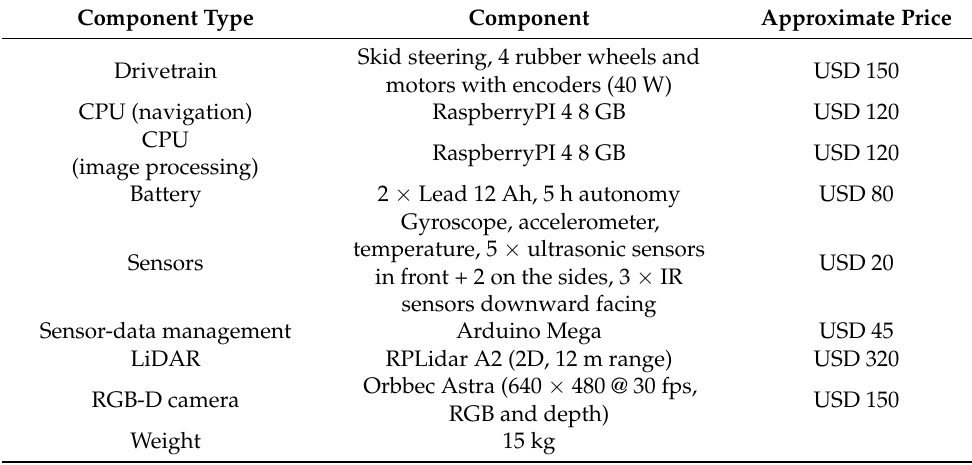
Table 1. Hardware specifications of the first